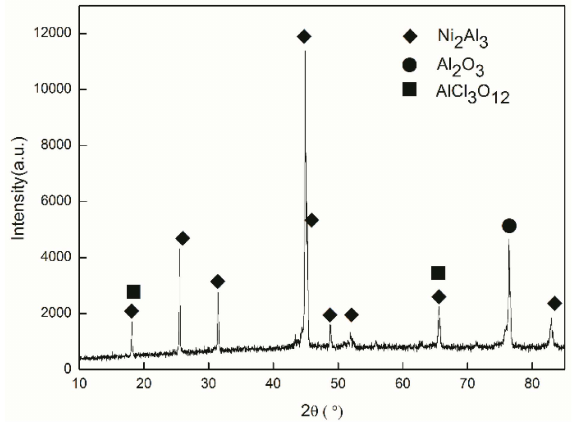
Figure 8. XRD pattern of the corrosion products on the coating surface after 30 d immersion.